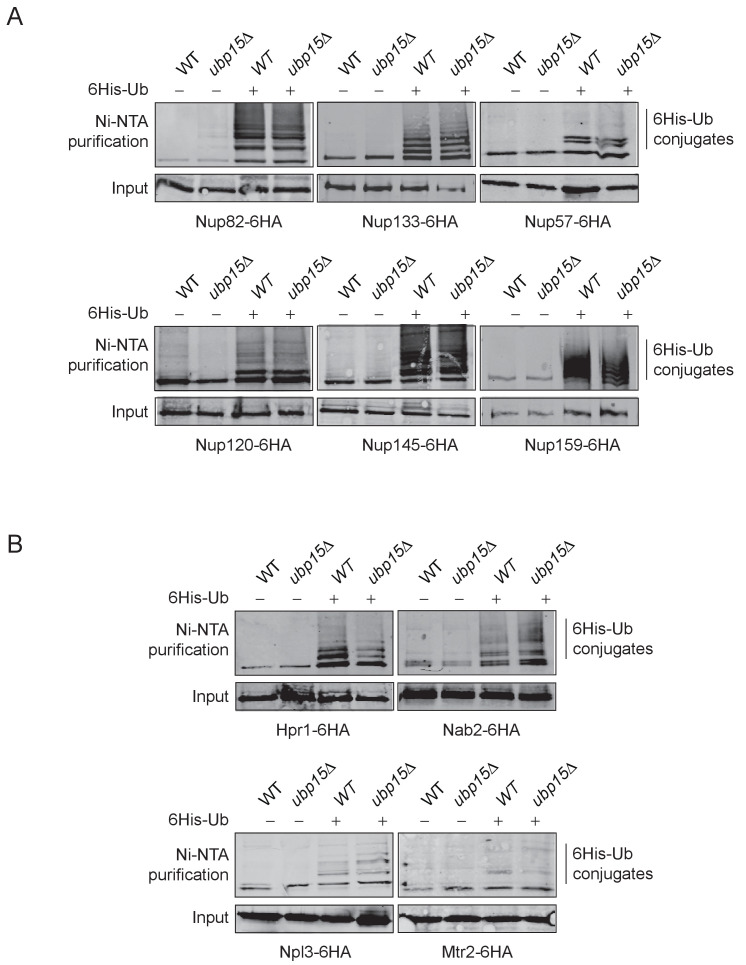
In vivo ubiquitylation assays testing for various Ubp15 possible substrates.(A) Western blots for NPC components (Nup82-6HA, Nup133-6HA, Nup57-6HA, Nup120-6HA, Nup145-6HA, and Nup159-6HA) levels from His-tagged ubiquitin-conjugated protein pulldowns (Ni-NTA) and their inputs expressing (+) or not (−) 6His-Ub in WT and ubp15Δ cells. (B) Western blots for nuclear export factors (Hpr1-6HA, Nab2-6HA, Npl3-6HA, and Mtr2-6HA) levels from His-tagged ubiquitin-conjugated protein pulldowns (Ni-NTA) and their inputs expressing (+) or not (−) 6His-Ub in WT and ubp15Δ cells.